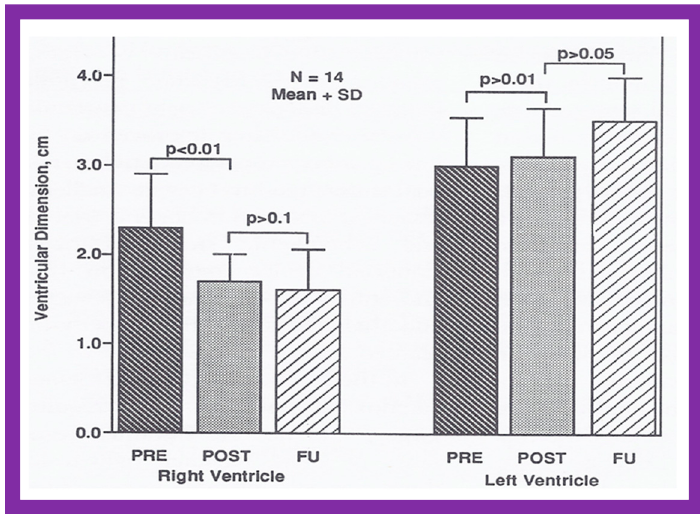
Figure 36. Changes in the end-diastolic diameters of the right ventricle ( left panel ) and left ventricle ( right panel ) following percutaneous occlusion of atrial defects are demonstrated in the above bar graph. The panel on the left illustrates decreased ( p < 0.01) size of the right ventricle shortly after occlusion (POST) of the atrial septal defect (ASD). At follow-up (FU), there was a further, but not statistically significant ( p > 0.1), reduction in the end-diastolic measurements of the right ventricle. The panel on the right shows no statistically important alteration ( p > 05) in the left ventricular dimension either immediately following atrial defect occlusion or during follow-up. The mean + SD (standard deviation) is shown for each measurement. N, number of patients; POST, on the day after ASD occlusion; PRE, before ASD occlusion. Reproduced from Reference [60].